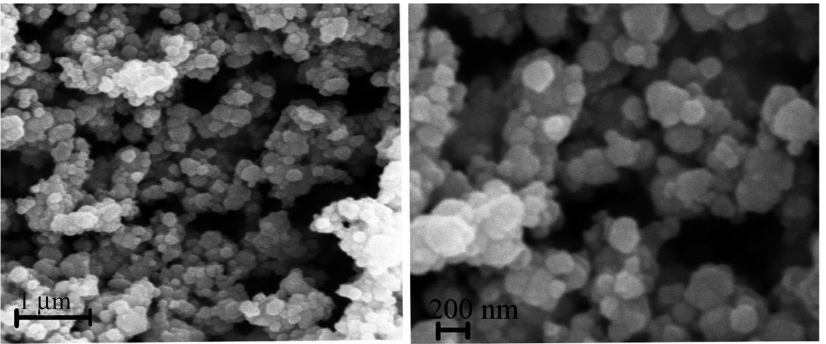
Figure 2: SEM images of NiS 2